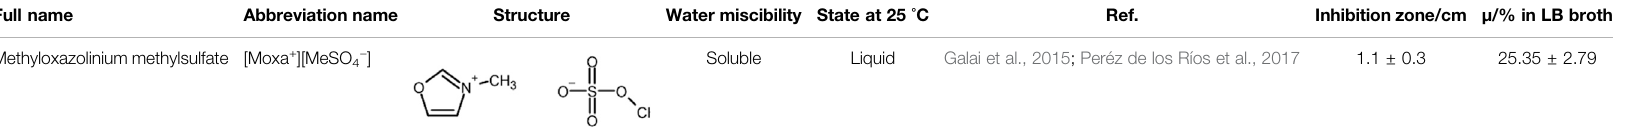
TABLE 6 | Oxazolinium-based ionic